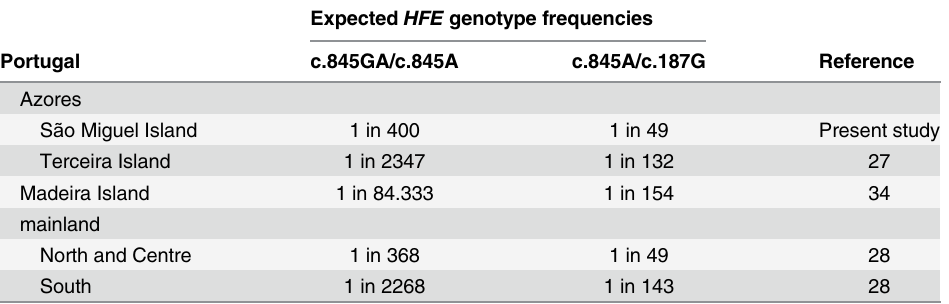
Table 5. Expected number of individuals homozygous or compound-heterozygous for the HFE - c.845G > A [p.Cys282Tyr] or -c.187C > G [p.His63Asp] in Azores, Madeira, and mainland